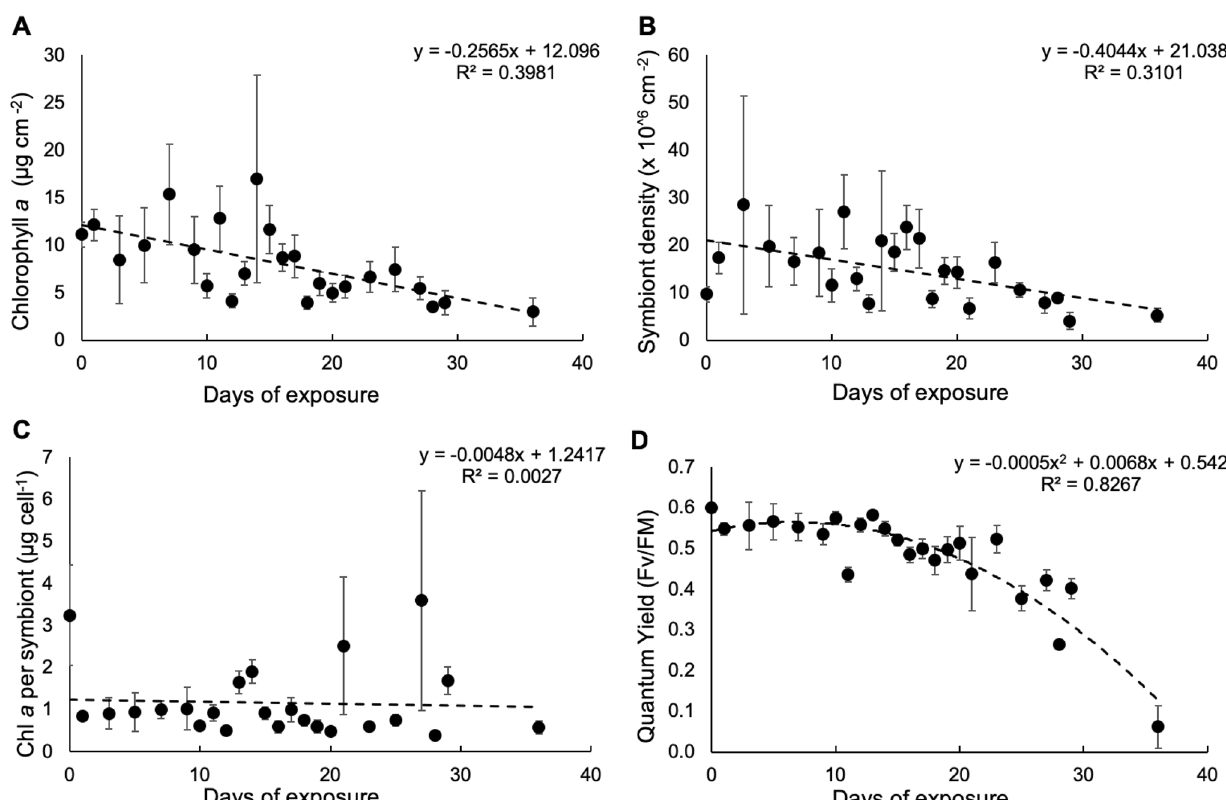
pooled across species collected during Phase I experiment. Data in A – C are fitted with a linear regression and D is fitted with an expo- nential curve and error bars are SE of